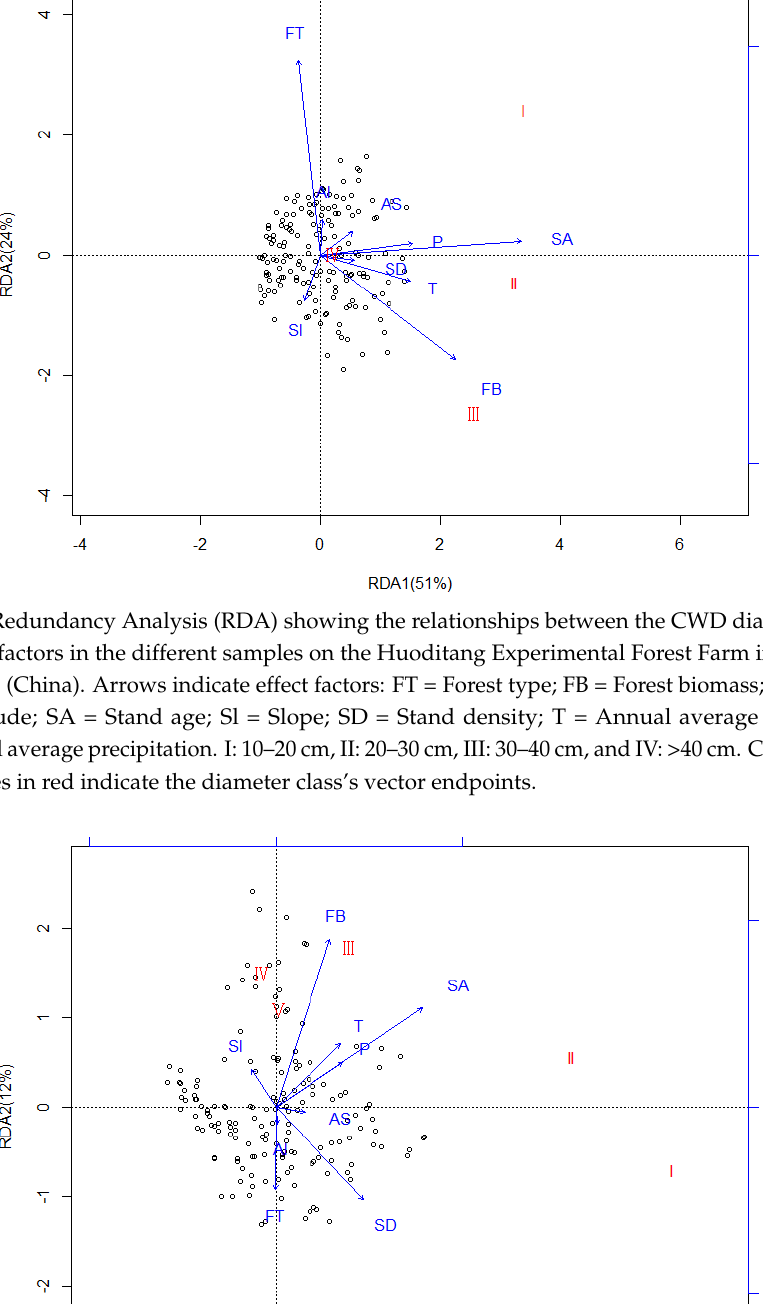
Figure 8. Redundancy Analysis (RDA) showing the relationships between the CWD compositions (logs, snags, and stumps) and effect factors in the different samples on the Huoditang Experimental Forest Farm in the Qinling Mountains (China). Arrows indicate effect factors: FT = Forest type; FB = Forest biomass; AS = Aspect; Al = Altitude; SA = Stand age; Sl = Slope; SD = Stand density; T = Annual average temperature; P = Annual average precipitation. CWD composition names in red indicate the composition’s vector endpoints.